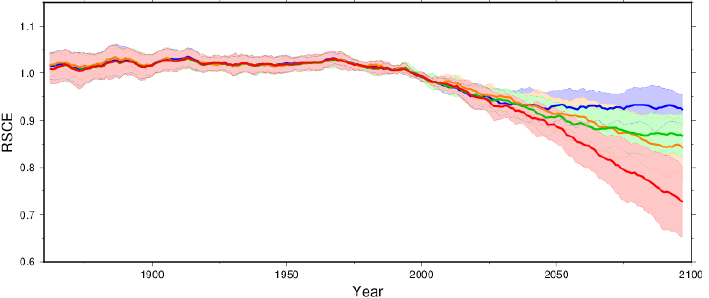
Figure 7: Projected NH March-April average seasonal snow cover extent (RSCE, relative to the 1986-2005 reference period) for the different RCP scenarios (blue : RCP2.6; green: RCP4.5; yellow: RCP6.0; red: RCP8.5), multi-model average over all available models for each scenario. The 5-year running average ensemble mean is taken for each individual model before the multi-model average is calculated. Inter-model spread is represented as plus or minus one standard deviation from the multi-model mean.